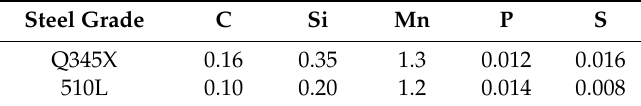
Table 3. Compositions of the di ff erent steels (wt%).